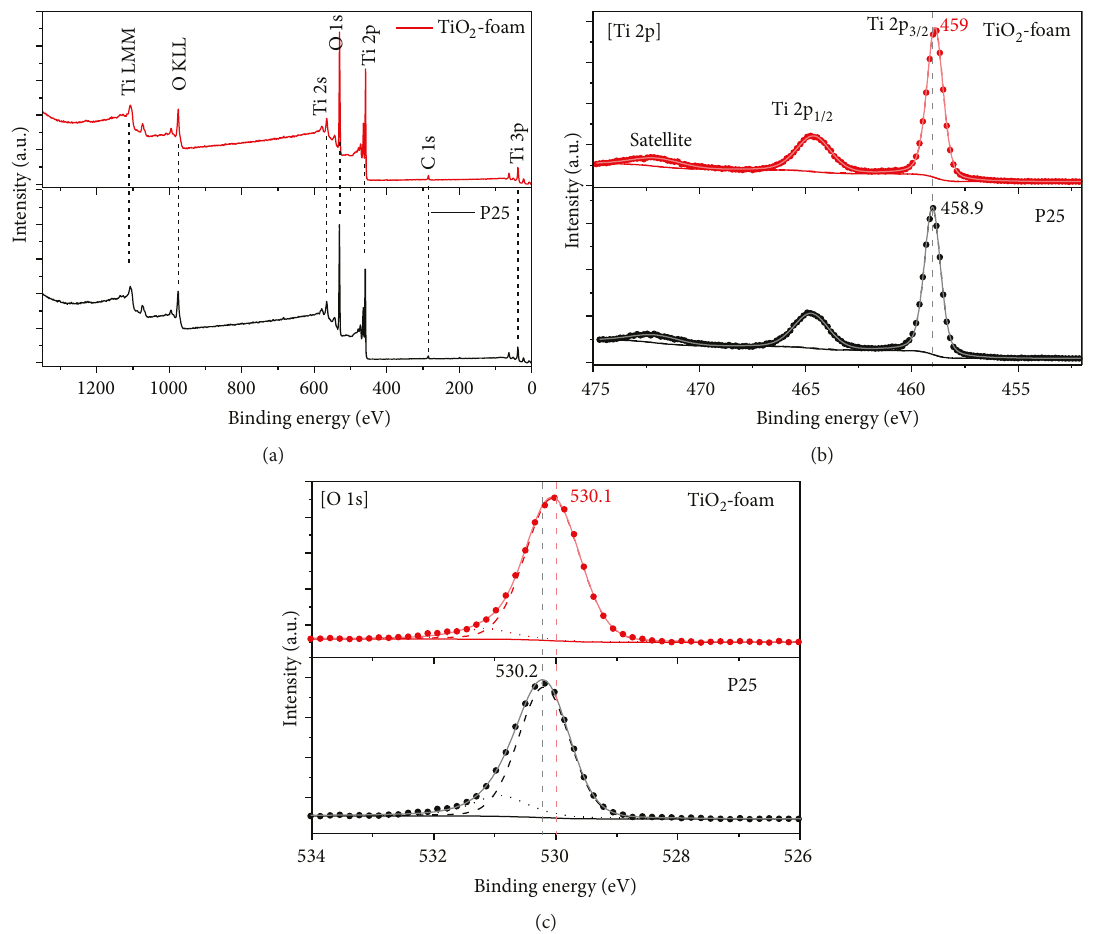
Figure 4: (a) XPS survey spectra of TiO